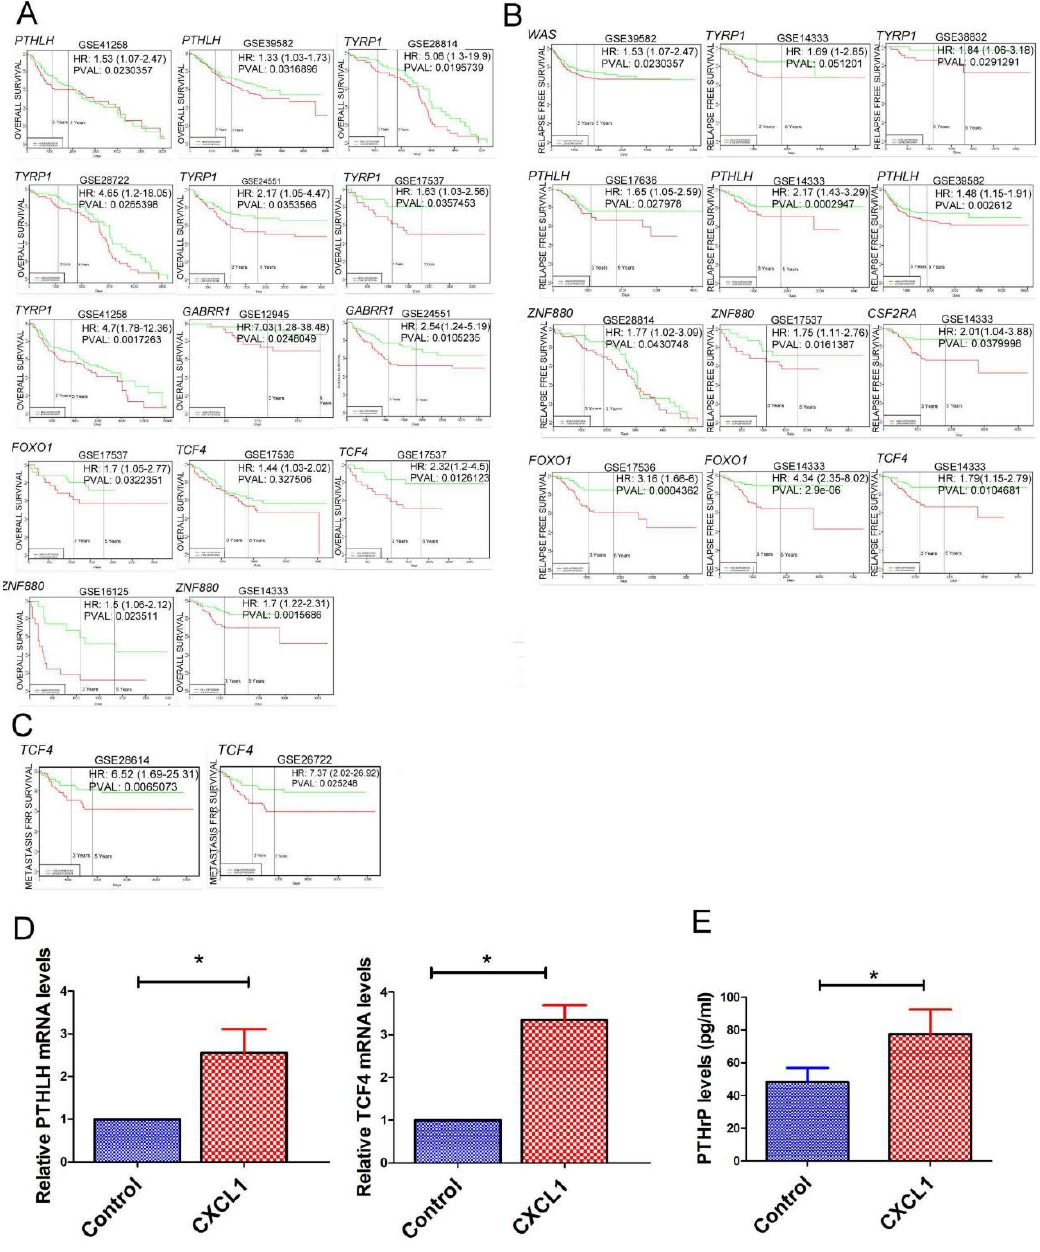
Figure 5. The correlation of CXCL1-regulated genes with CRC patient outcome. The correlation of overall survival ( A ), relapse-free ( B ) and metastasis-free rates ( C ) with CXCL-1 regulated genes. ( D ) The effect of CXCL1 in the expression of PTHLH and TCF4 at mRNA levels. CXCL1 increased the expression of PTHrP ( E ) in SW620 cells. SW620 cells were treated with CXCL1 for 24 h, and the expressions of PTHLH and TCF4 were determined by qRT-PCR and ELISA, respectively. Each value is the mean ± SD of three determinations. * Significant difference between the two test groups ( p < 0.05) (*).